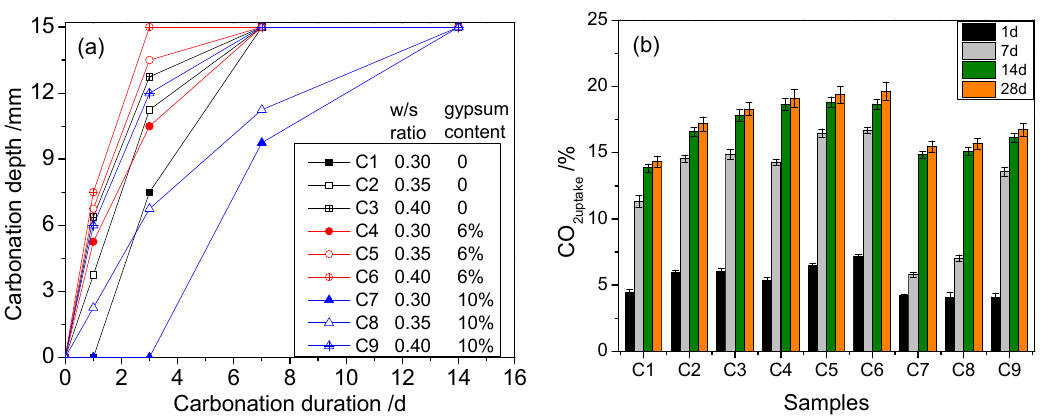
Figure 5. Carbonation depth ( a ) and CO 2 uptake ( b ) results of samples.